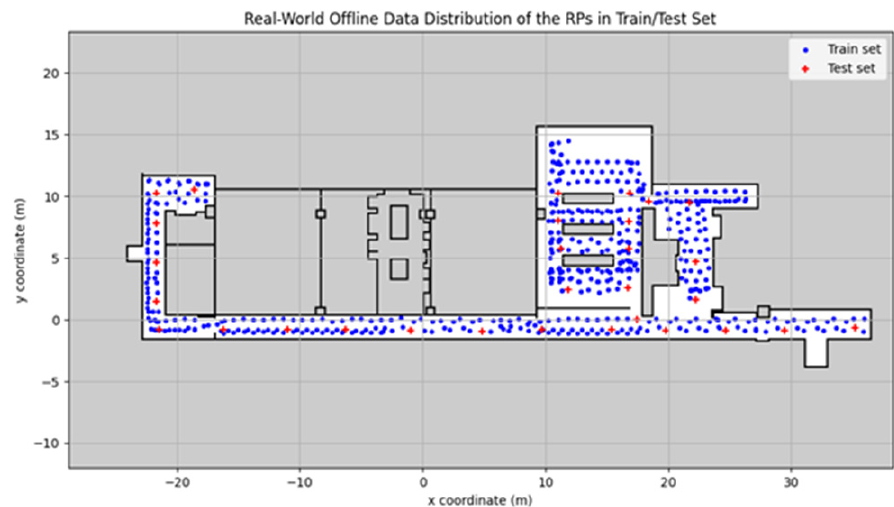
Figure 10. Distribution of the RPs for a train/test in a real environment for offline data with entropy.